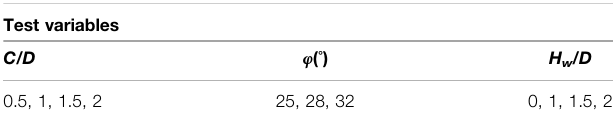
TABLE 2 | Conditions of centrifuge model tests.